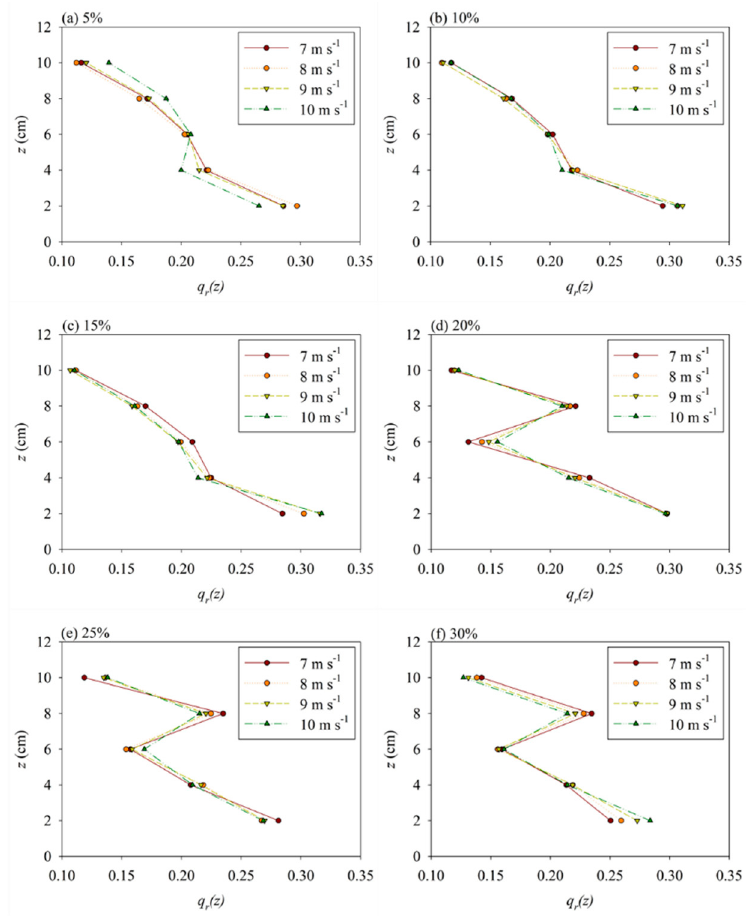
Figure 6. Comparison of vertical profiles of relative blown-sand flux q r ( z ) in Equation (3) for gravel coverages of ( a ) 5%, ( b ) 10%, ( c ) 15%, ( d ) 20%, ( e ) 25%, and ( f ) 30% for the same wind speeds as in Figure 5.